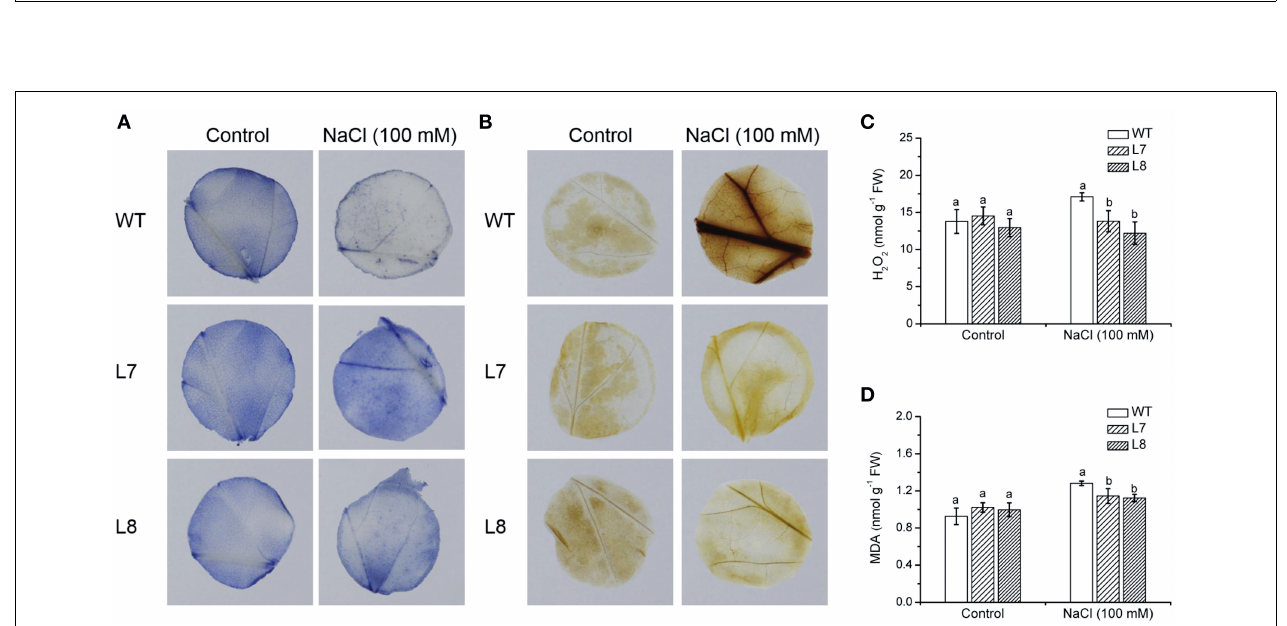
(C) Ratio of variable to maximal chlorophyll fluorescence (Fv/Fm), (D) Actual photochemical efficiency of PSII ( (cid:4) PSII). Each column is the mean of 4–6 replicates. Bars represent standard error of the mean. Different letters above columns represent significant differences at P < 0 . 05 between WT and transgenic lines in control and NaCl treatments.